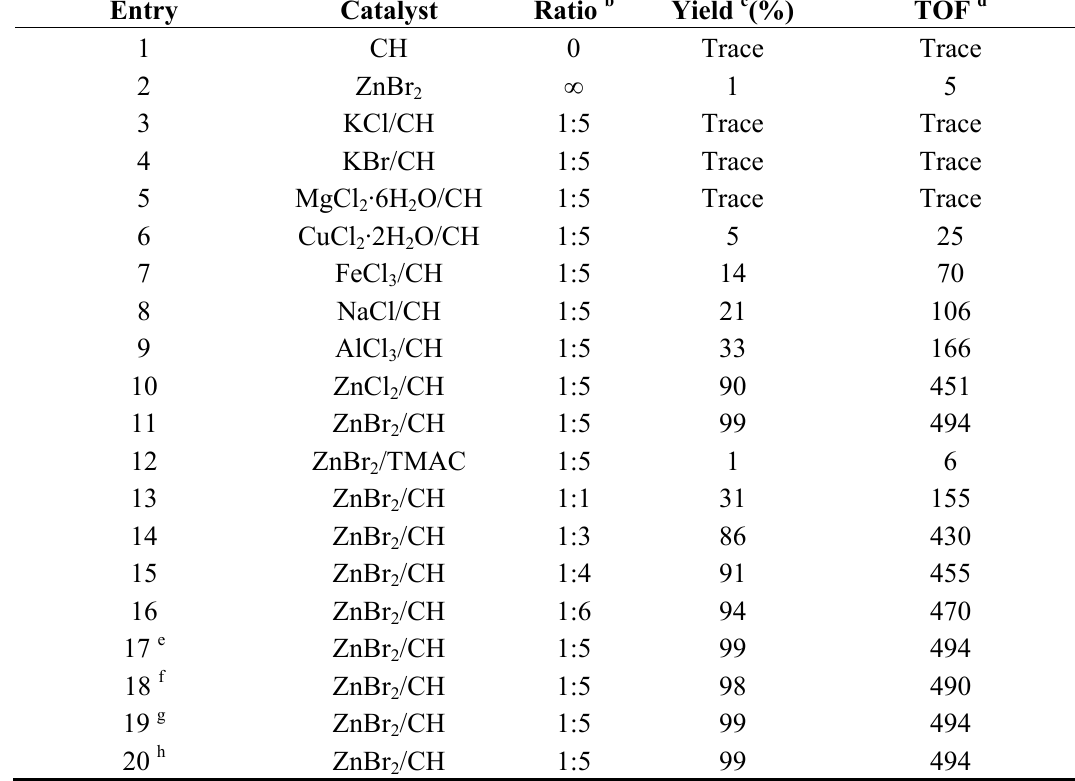
Table 3. Effects of different metal compounds combined with choline chloride (CH) on the coupling reaction of CO and PO a 2